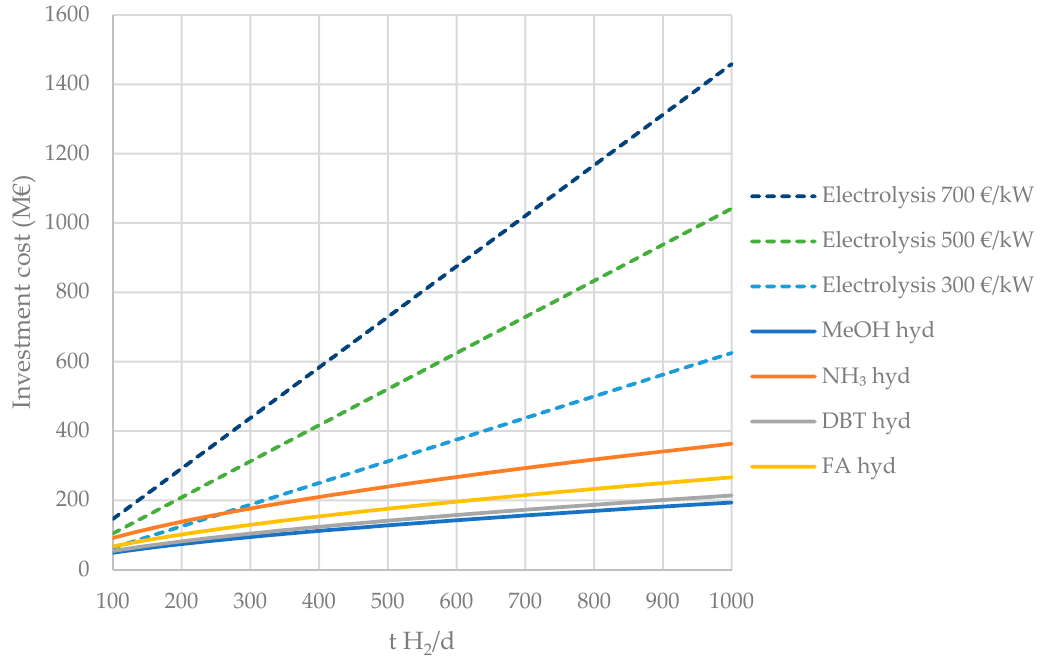
Figure 6. Investment costs of electrolyzer overcapacity and hydrogenation plants for different liquid H 2 carriers.